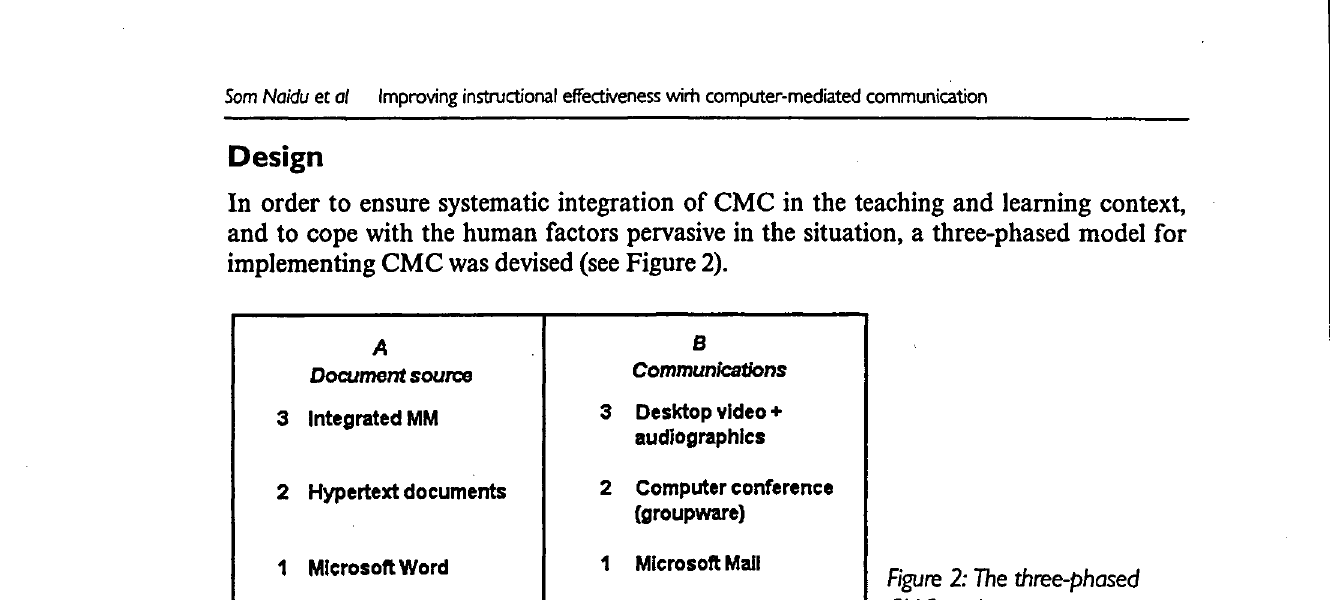
figure 2:7?ie three-phased CMC